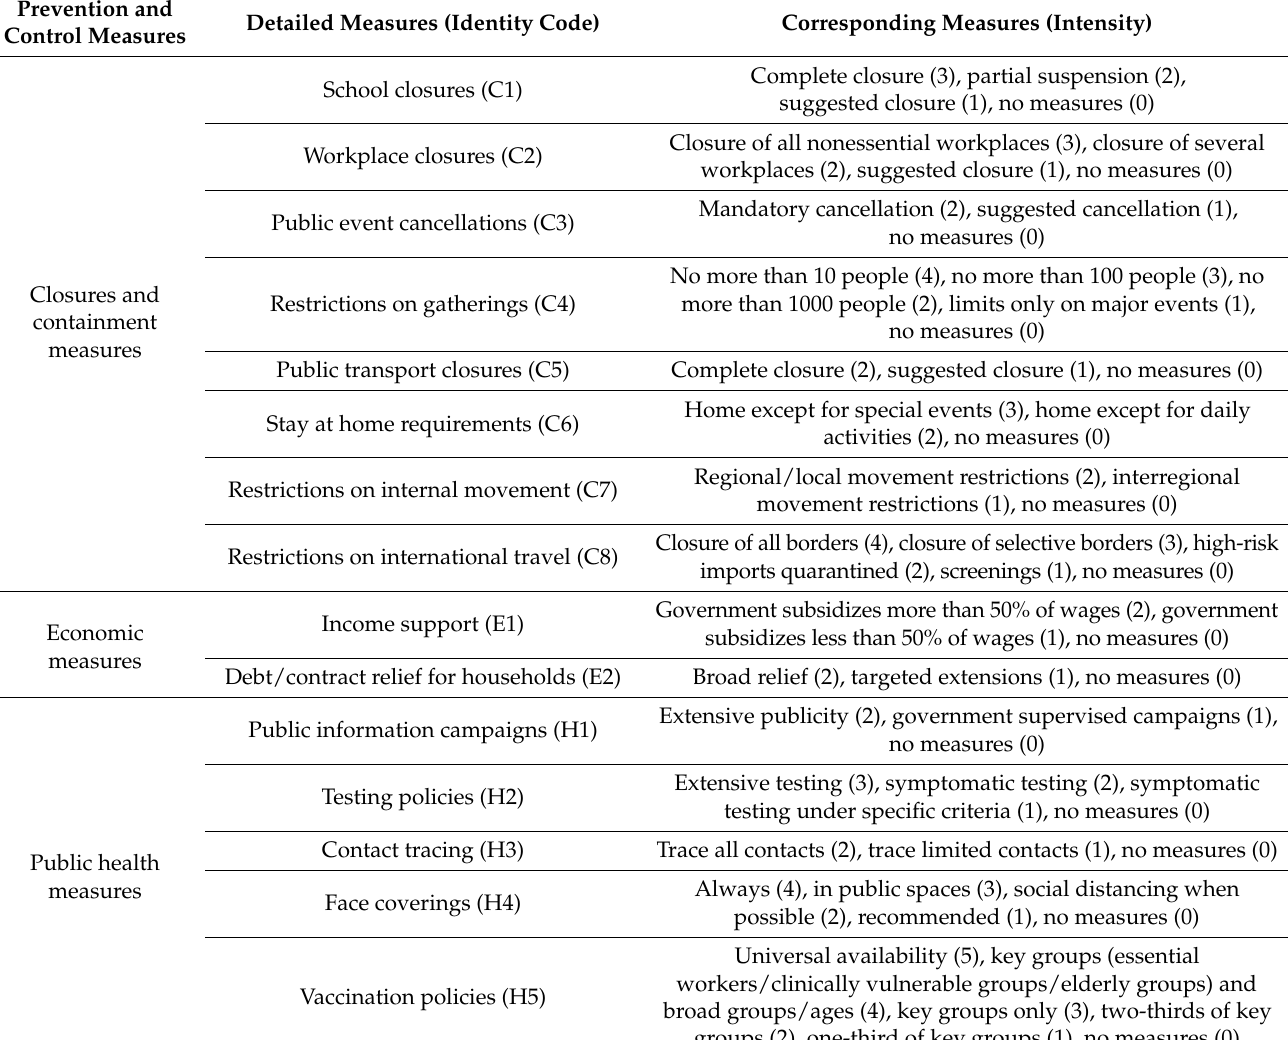
Table 1. Description of the specific intervention